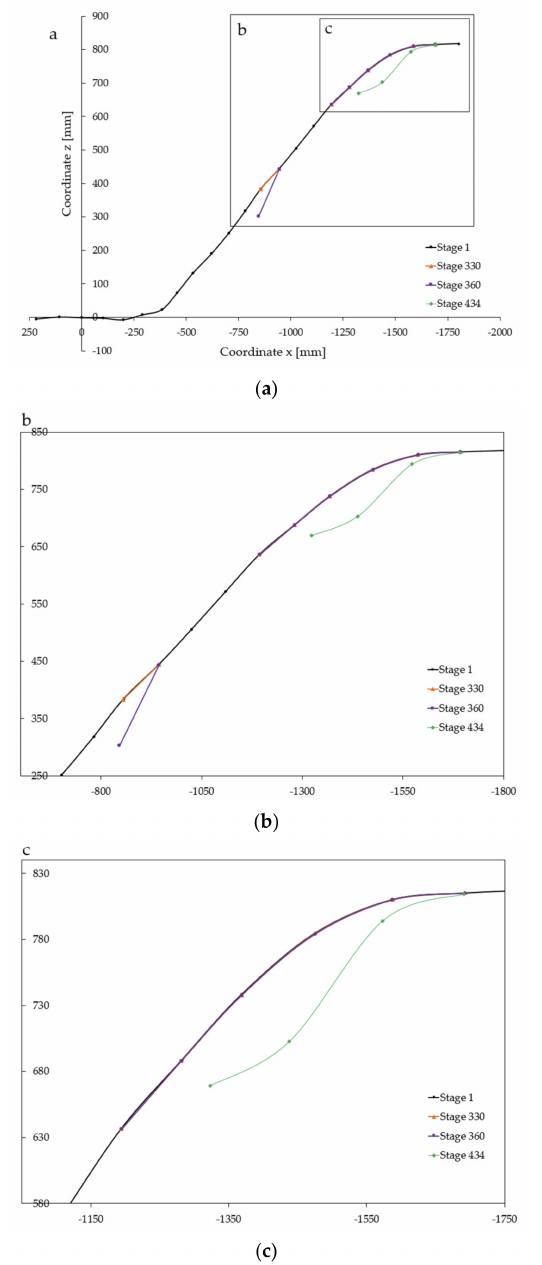
Figure 12. Graphical display of longitudinal profile with enlarged display of points displacement: ( a ) profile displacement of points in Stages 1, 330, 360, and 434; ( b ) profile displacement of points 13 to 22 (points 15 and 16 lost); ( c ) profile displacement of points 17–22